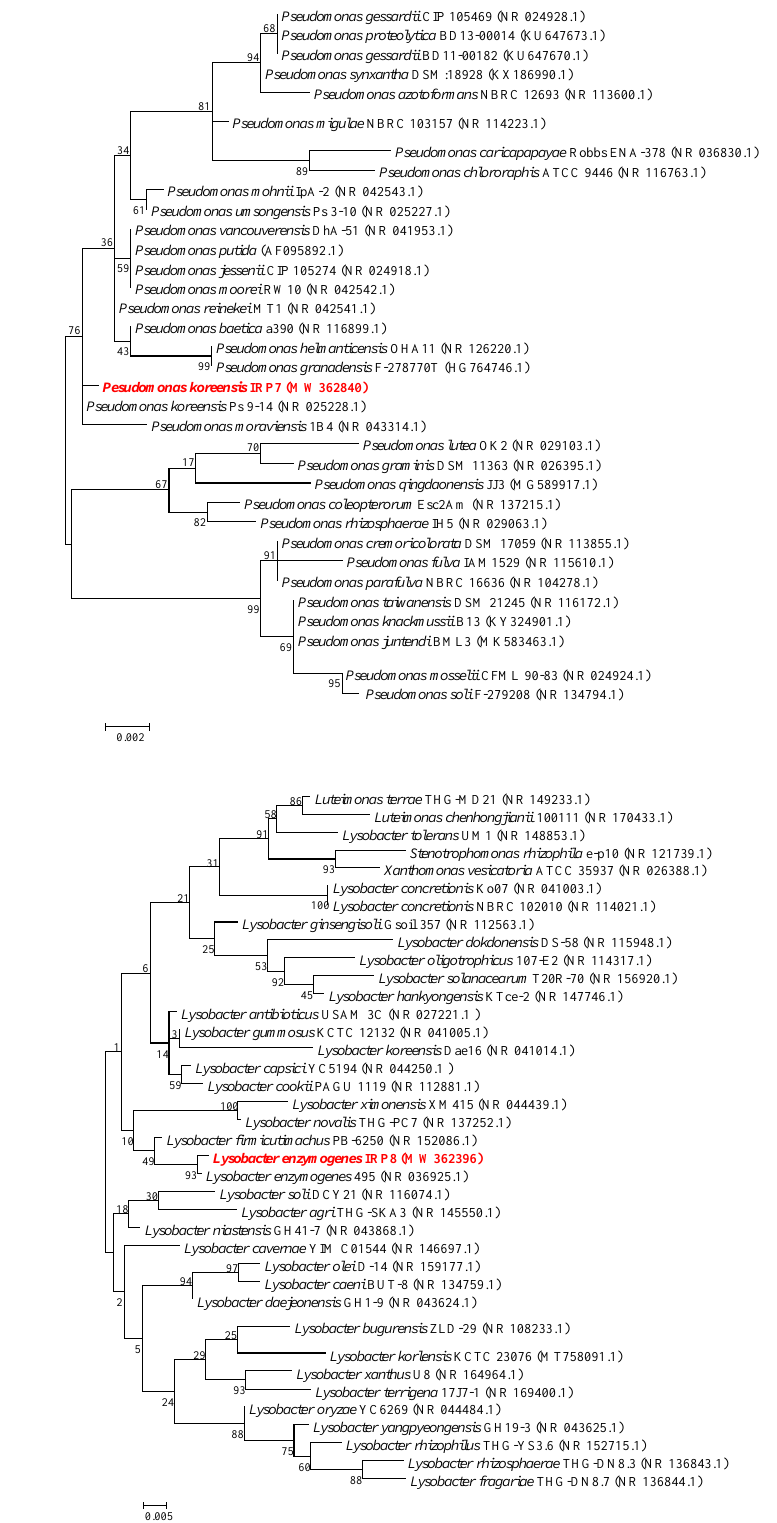
Figure 7. Maximum-likelihood phylogenetic tree based on the 16s rRNA sequences for taxonomic position and relationships among type strains of related species for ( A ) Pseudomonas koreensis IRP7 and ( B ) Lysobacter enzymogenes IRP8. Bootstrap values of 1000 replicates are shown on the branching points. Bacterial species names are followed by strain names and accession numbers of the sequences in